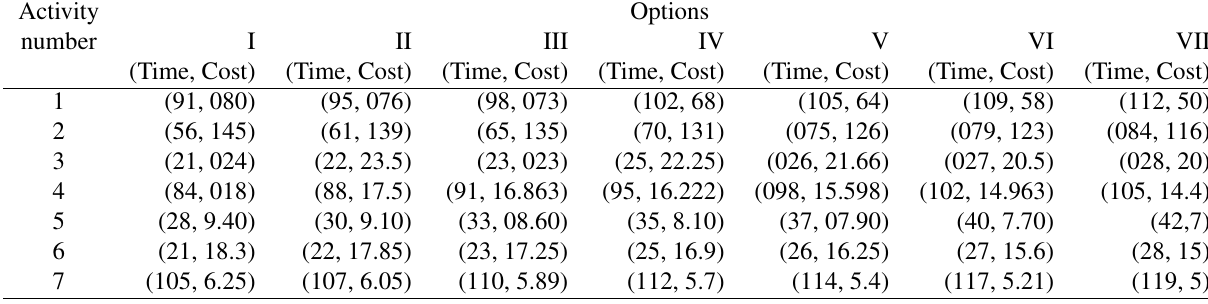
Table 3. Network data of third case